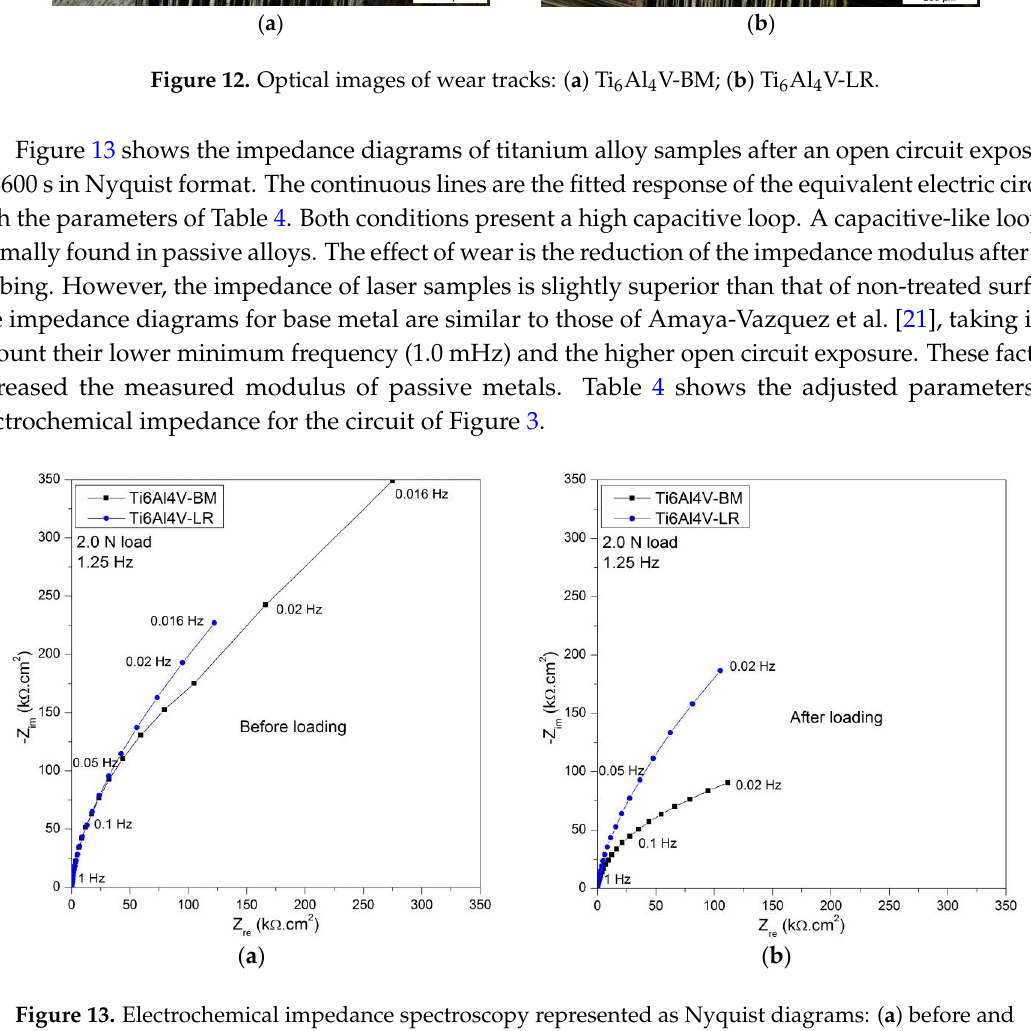
Figure 11. Profile of wear tracks obtained after the polarization curve tests.